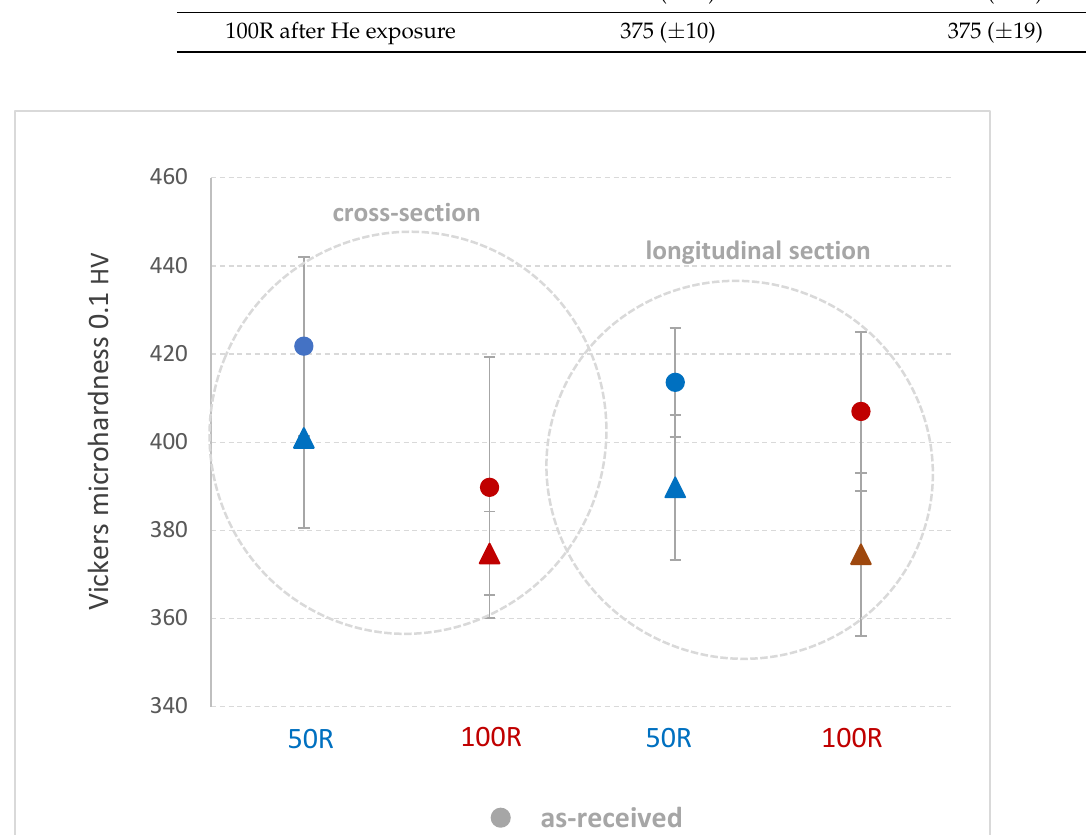
Diagram 6. Comparison of Vickers microhardness 0.1 HV in the longitudinal direction and cross- sections of specimens before and after He exposure.